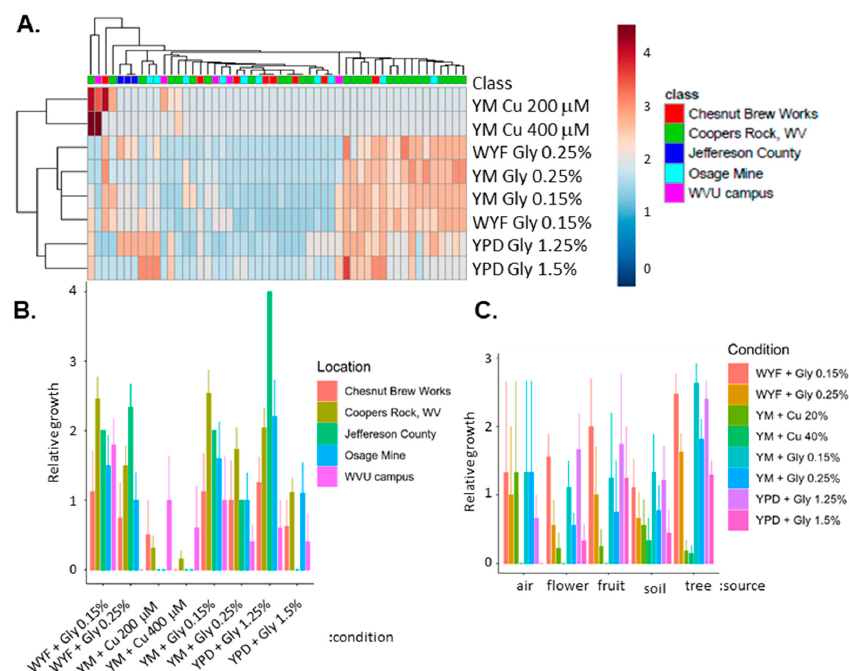
Figure 5. Phenotypic di ff erences of S. cerevisiae to di ff erent herbicide treatments. ( A ) Heatmap of hierarchical clustering of S. cerevisiae grown in eight di ff erent conditions. Yeast were serial diluted and grown on rich media (YPD), minimal media (YM), and minimal media supplemented with aromatic amino acids (WYF) with the noted amount of glyphosate w / v from the glyphosate-based herbicide (Credit41) or 200–400 µ M copper sulfate. Red noted robust growth while blue noted less growth. ( B ) Bar graph of S. cerevisiae growth in di ff erent herbicides across di ff erent locations. ( C ) Bar graph of S. cerevisiae growth in di ff erent herbicides across di ff erent sample sources. The explained variance is noted in parentheses.